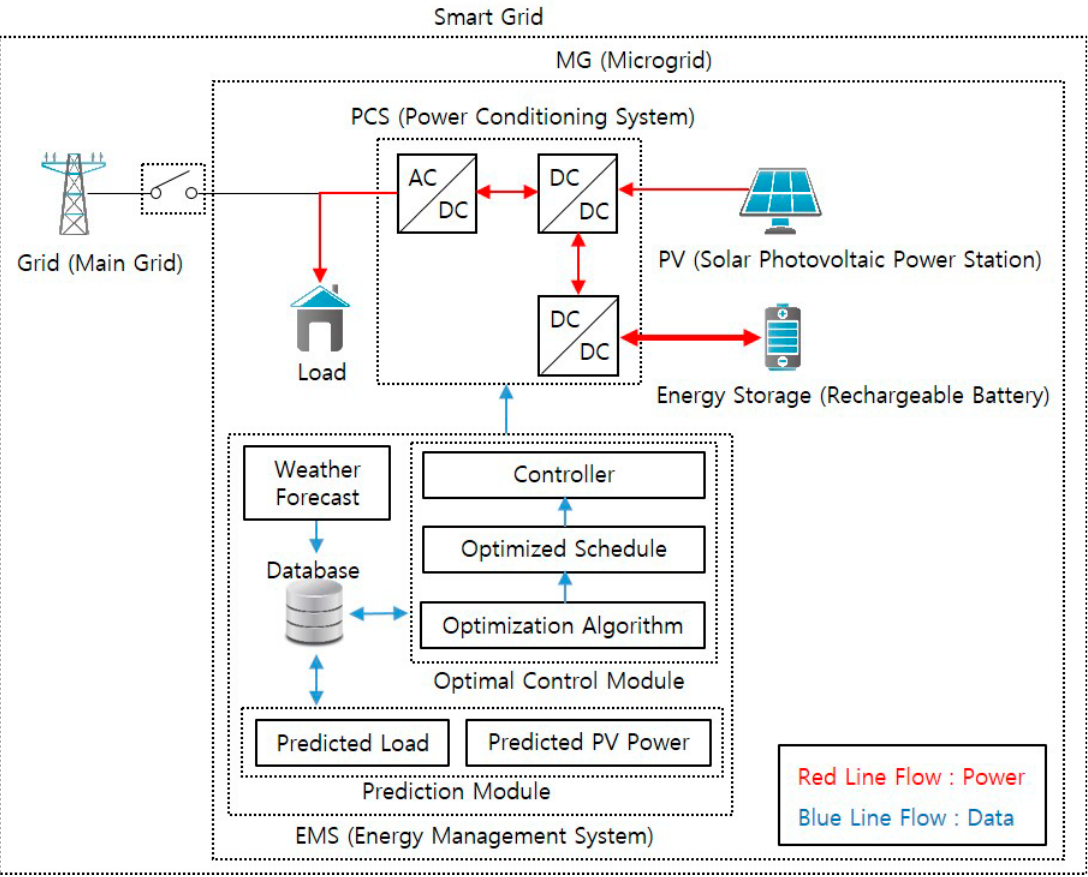
Figure 3. Schematic diagram of energy management system (EMS) platform controlling ESS with PV in island mode.